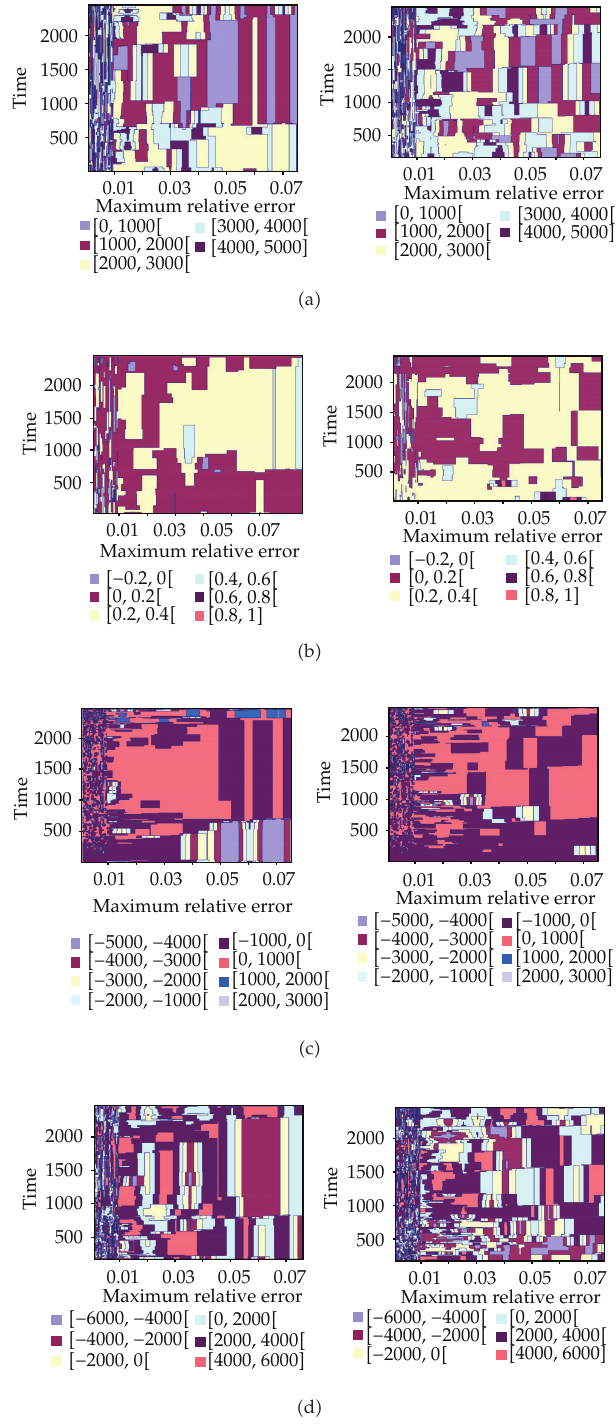
Figure 5: Locus of the parameters { a,b,c,d } versus (cid:2) ε, t (cid:3) , based on (cid:2) 2.2 (cid:3) , for the Dow Jones (cid:2) left (cid:3) and Nikkei (cid:2) right (cid:3) indices, from Jan. 2000 to Dec.